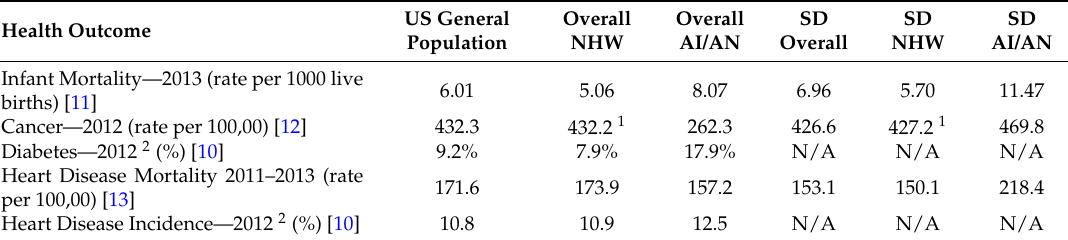
Table 1. American Indian/Alaska Native Health Outcomes.